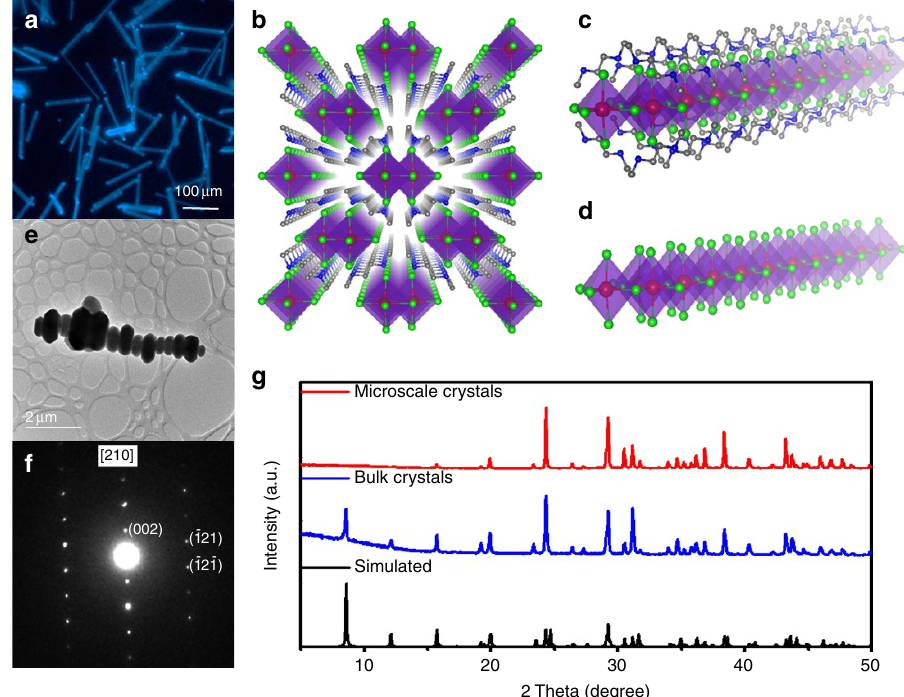
Figure 1 | Structural characterization of bulk and microscale 1D lead bromide perovskite crystals. ( a ) Optical image of needle-shaped 1D lead bromide perovskite single crystals. ( b ) Structure of 1D perovskite C 4 N 2 H 14 PbBr 4 (red spheres: lead atoms; green spheres: bromine atoms; blue spheres: nitrogen atoms; grey spheres: carbon atoms; purple polyhedrons: PbBr 6 4 (cid:2) octahedrons; hydrogen atoms were hidden for clarity). ( c ) View of an individual lead bromide quantum wire wrapped by the organic cations. ( d ) View of an individual lead bromide quantum wire with edge sharing octahedrons. ( e ) Transmission electron microscopy (TEM) image of the microscale 1D perovskite crystals. ( f ) Electron diffraction pattern along [210] zone axis. ( g ) Powder X-ray diffraction (PXRD) patterns of the bulk and microscale 1D perovskite crystals, as well as the simulated PXRD patterns based on the single crystal